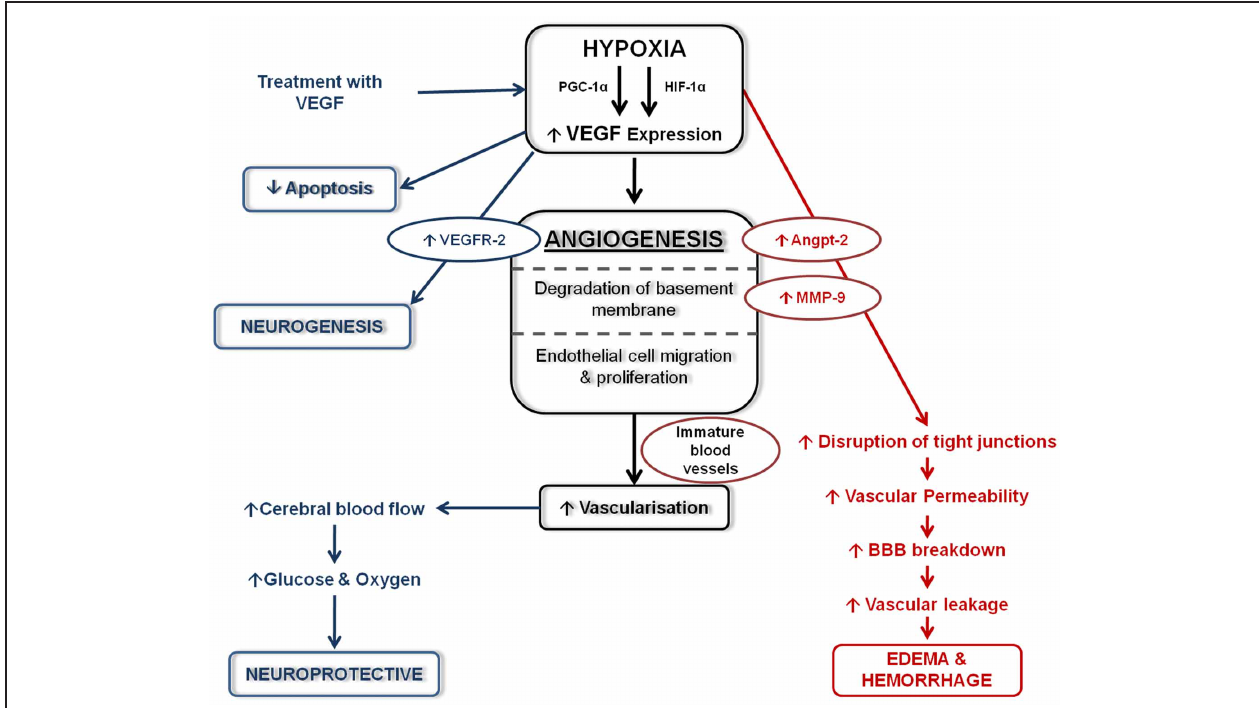
FIGURE 2 | Schematic diagram of the effects of VEGF following hypoxia. Following hypoxia, increased VEGF expression stimulated angiogenesis leading to increase vascularization. Increased VEGF expression can have